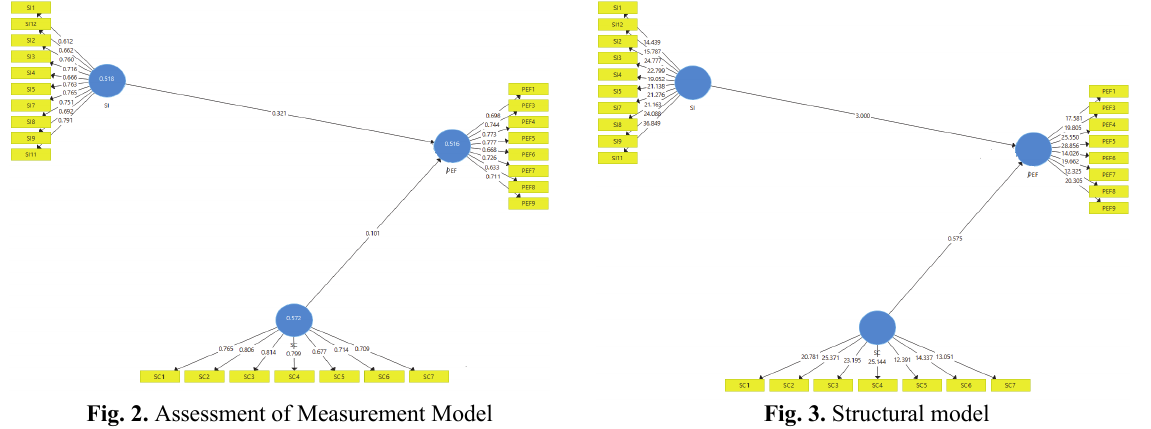
Fig. 2. Assessment of Measurement Model Fig. 3. Structural model